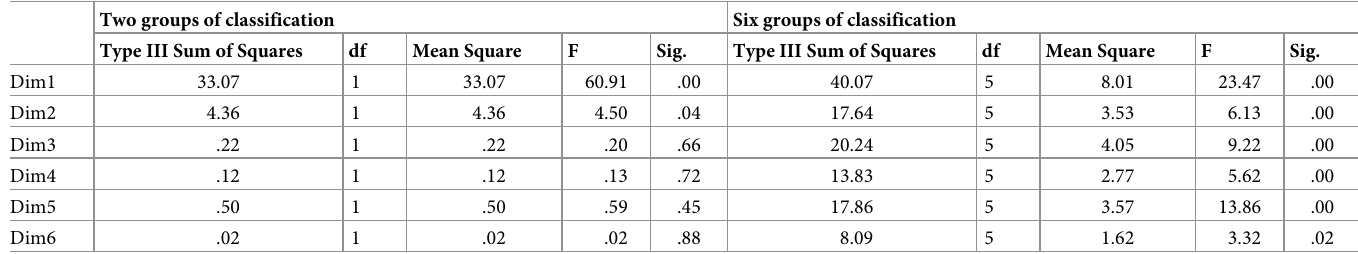
Table 7. Sample 16 had the lowest satisfaction, Mean = 3.54, SD = .73. Sample 16 and its Table 4. Classification rationality